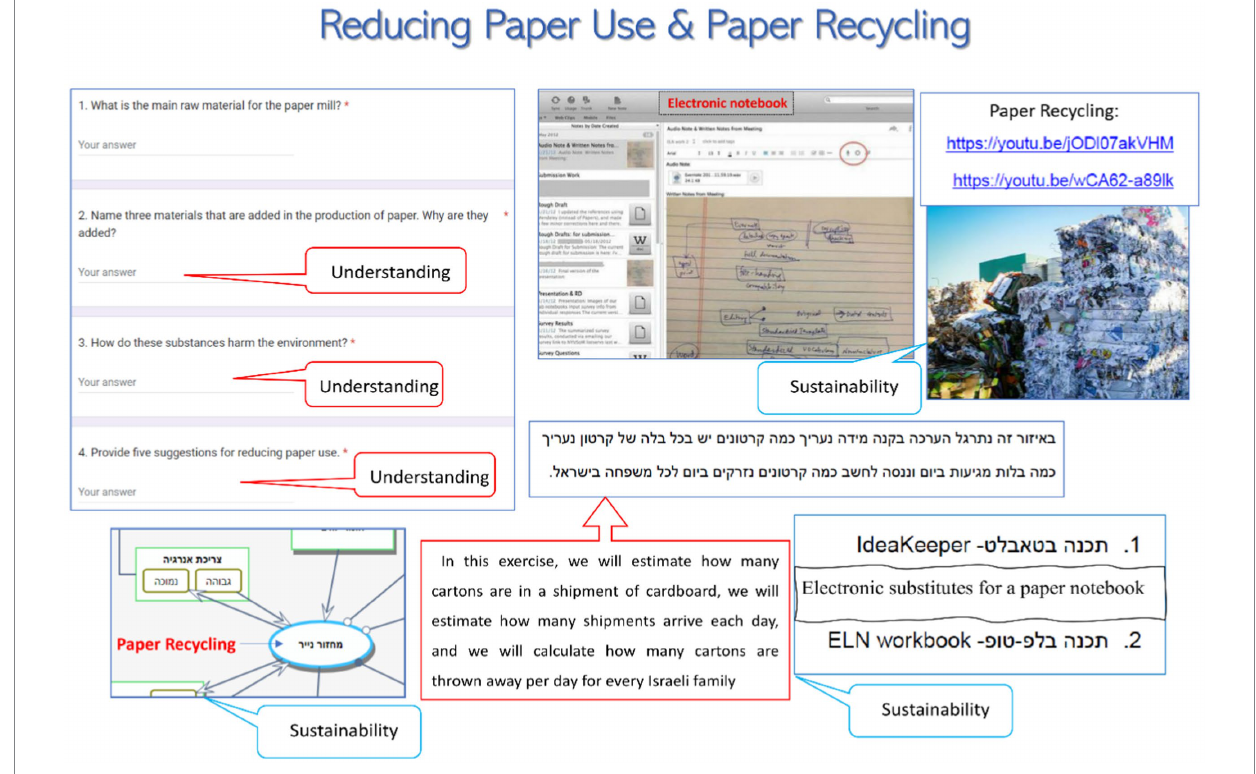
FIGURE 5 Selected segments from Ron’s paper recycling assignment. The left-bottom part was not included in the assignment, but it appears in an appendix along with his